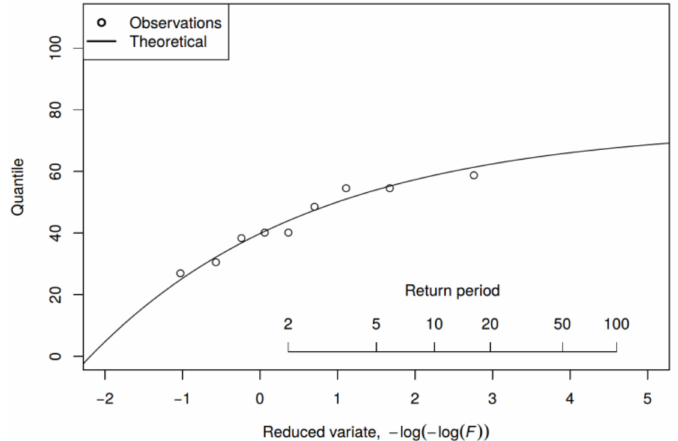
Figure 3. Theoretical fitting of the Generalized Extreme Value (GEV) probability density function